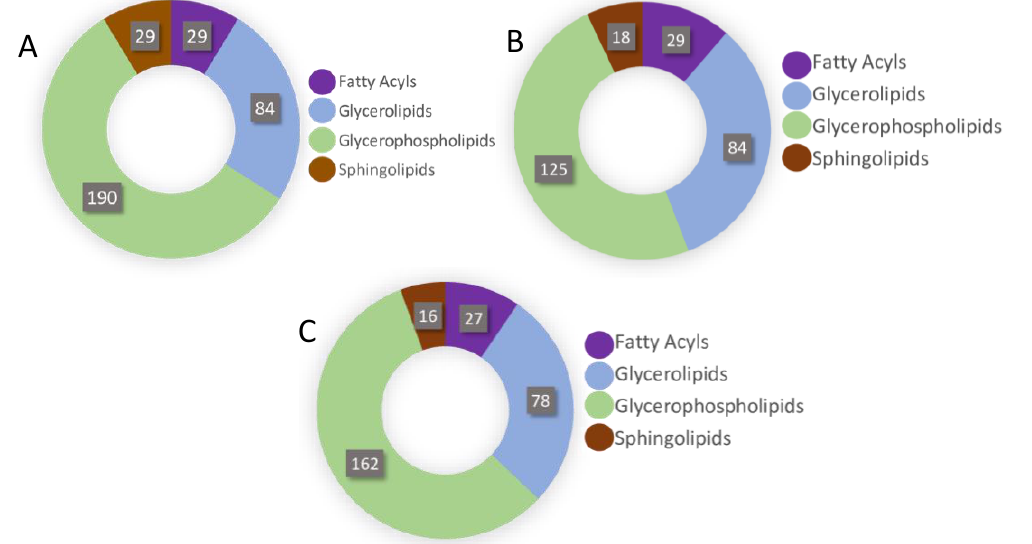
Figure 6. Distribution of putative lipids by lipid classes: ( A ) in the somatic extract of infective third-stage larvae (L3) of N. brasiliensis (NB_SE); ( B ) in the excretory / secretory products (ESP) of N. brasiliensis L3 (NB_ESP); ( C ) in the somatic extract of T. muris embryonated eggs (TM_SE).